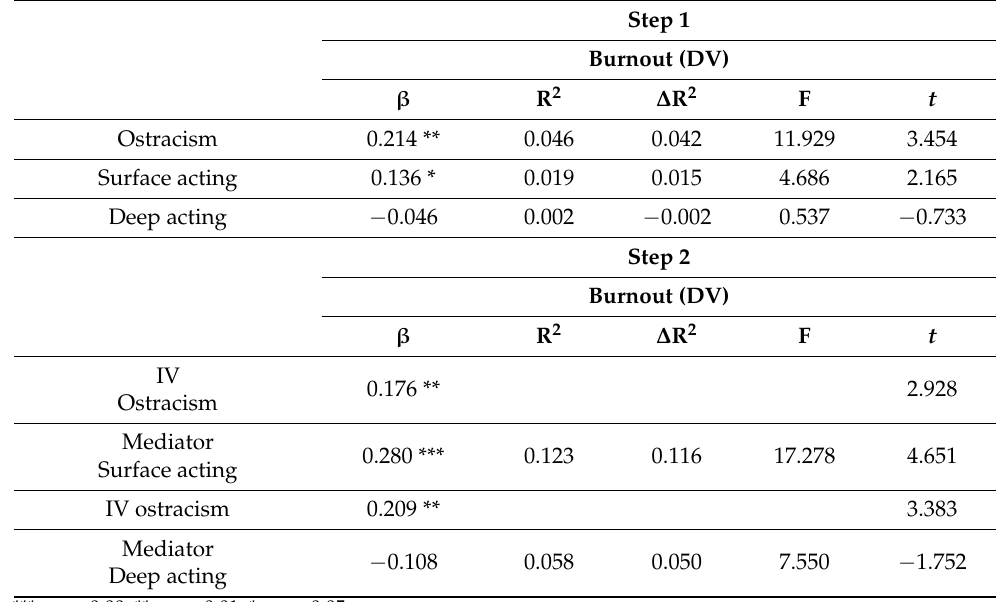
Table 2. Results of regression